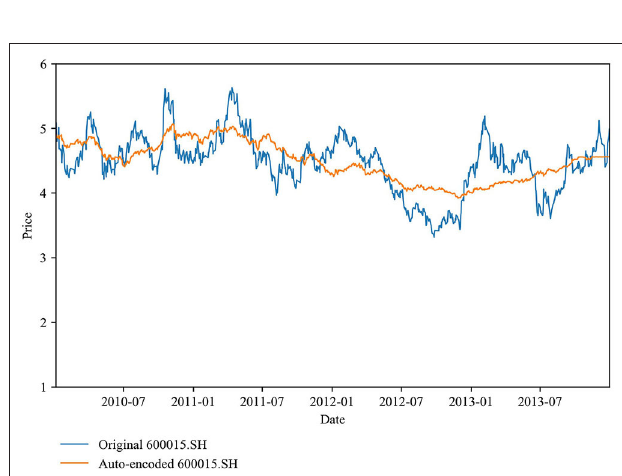
FIGURE 9 | Stock (600015.SH) with the least communal information: the prices of the actual and auto-encoded stocks differ significantly across the period